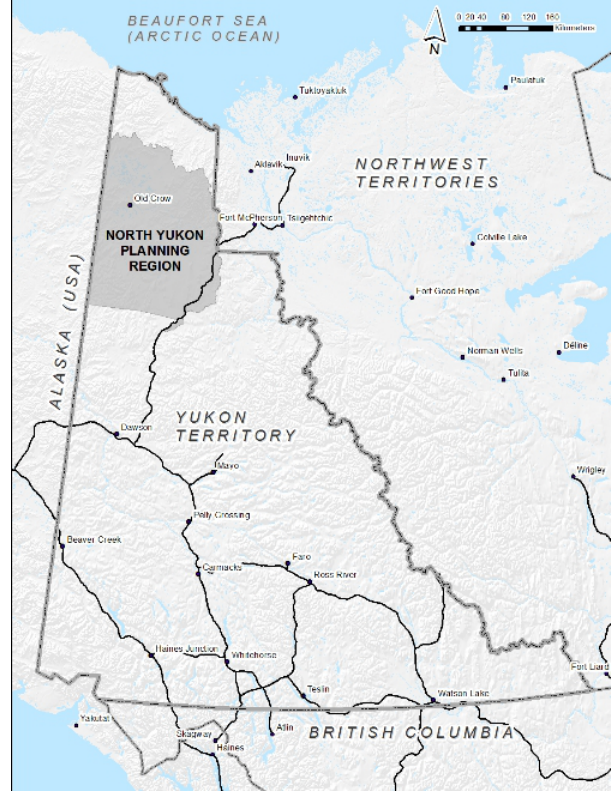
Fig. 1 . Location of North Yukon Planning